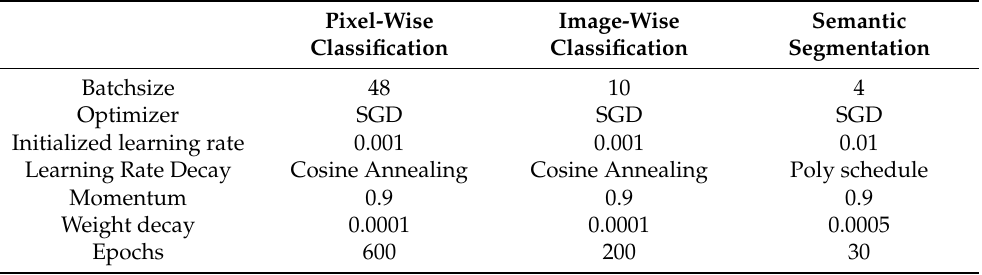
Table 3. Training settings on different downstream tasks. Pixel-Wise